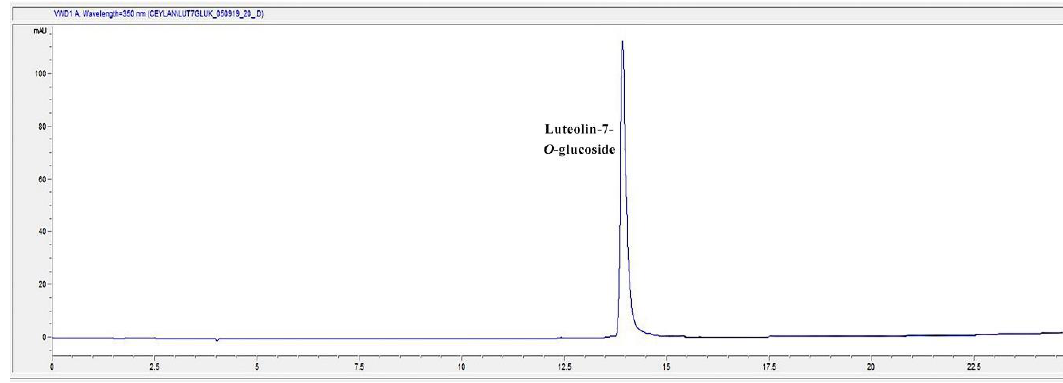
Figure 9. The HPLC Chromatogram of luteolin-7- O -glucoside (Retention time: 13.9 min).